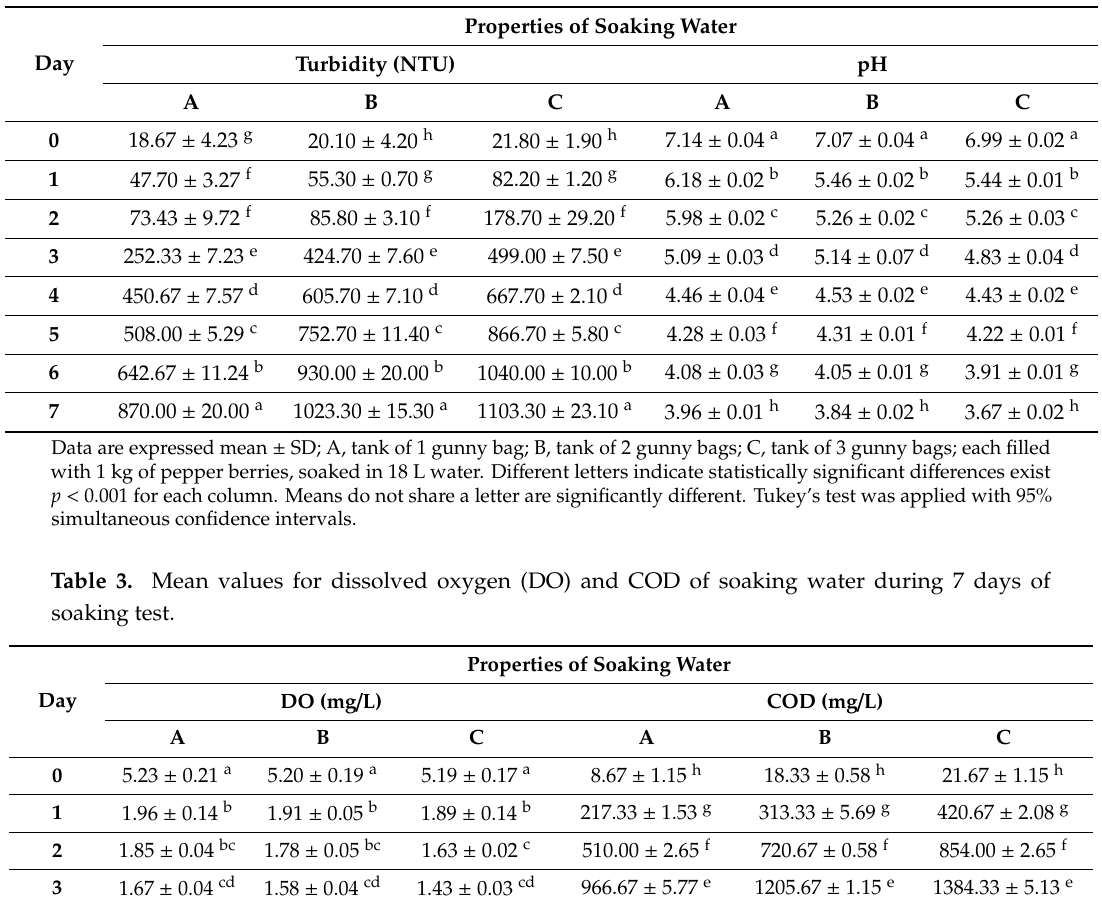
Table 2. Mean values for turbidity and pH of soaking water during 7 days of soaking test.